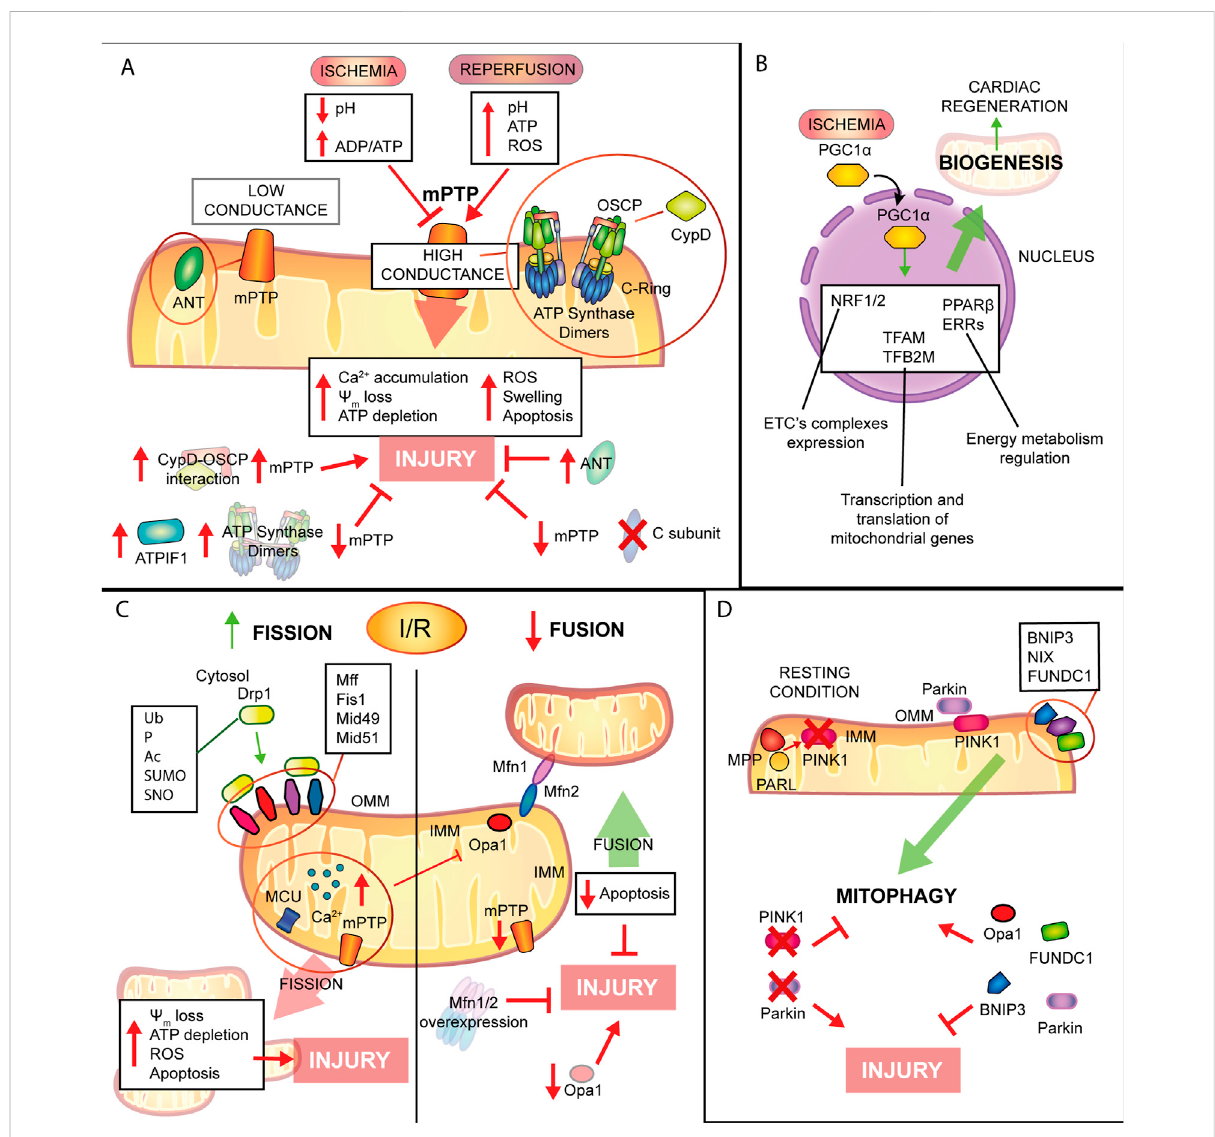
FIGURE 4 Mitochondrial remodelling and state of health in I/R condition. (A) mPTP involvement in IRI. Schematic representation of the main molecular eventsinvolvingmPTP inIRI.During ischemiamPTP opening isinhibited,after reperfusion thismultiproteincomplexopeningtriggersmitochondrial reactions which lead to cardiomyocytes death. (B) . Mitochondrial biogenesis. The biogenic process is activated during ischemia with positive consequences in order to improve cellular metabolism and energy production and to promote cardiac regeneration. (C) . Mitochondrial dynamics. Fission process is enhanced during I/R leading to tissue injury. Contrariwise, mitochondrial fusion is reduced and increase of this process showed bene fi cial effects against IRI. (D) . Mitophagic process. Induction of mitophagy during myocardial infarction has cardioprotective effects on the condition that is not a chronic activation, very harmful for cardiac